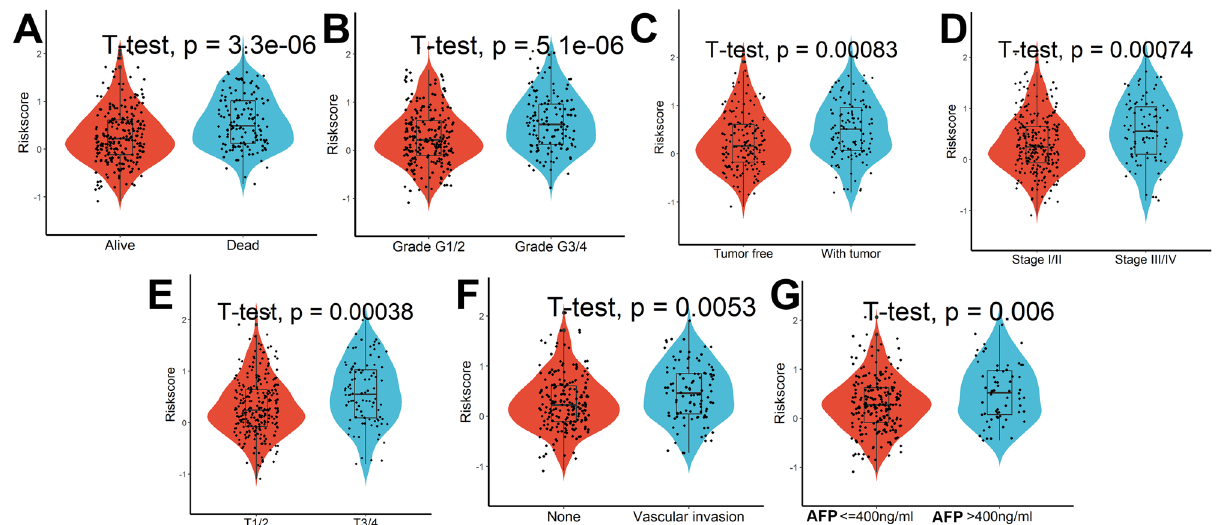
Figure 5. Relationship between Cuproptosis-related lncRNA signature and clinical characteristics. Analysis of differences in risk scores between patients with different survival status ( A ), grade ( B ), recurrence status ( C ), TNM stage ( D ), T stage ( E ), vascular invasion ( F ), and levels of AFP ( G ).